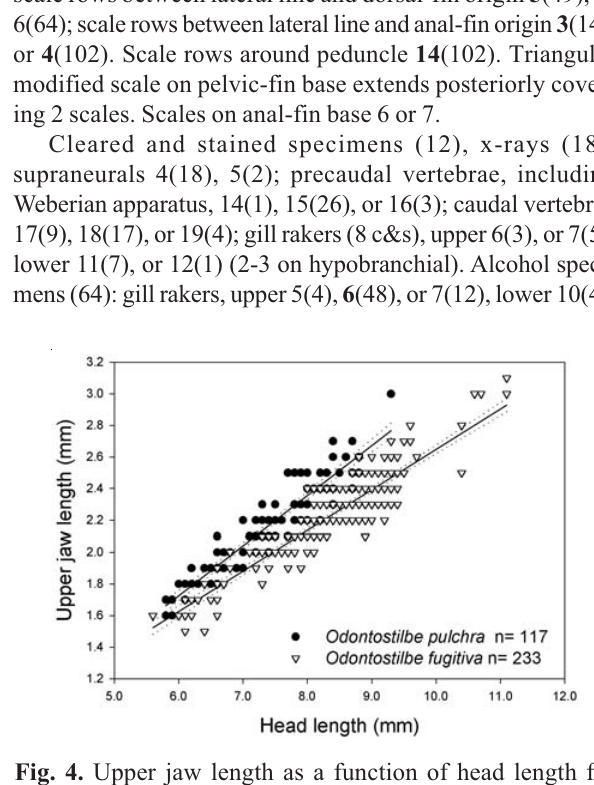
Fig. 2. Anal-fin base length as a function of standard length for males of Odontostilbe pulchra , against O. fugitiva .